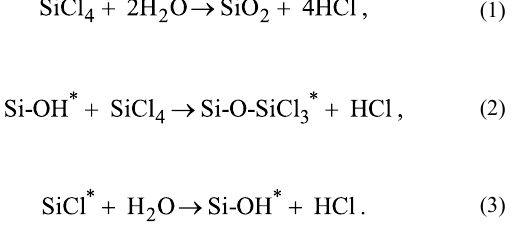
include (a) irradiation of polymer foils with a well-defined number of approx. 2 GeV heavy ions, (b) chemical etching that converts each individual ion track into a cylindrical channel; the etching time determines the channel diameter (120 s etching resulted in channels of about 50 nm in diameter), and (c) SiO 2 coating by